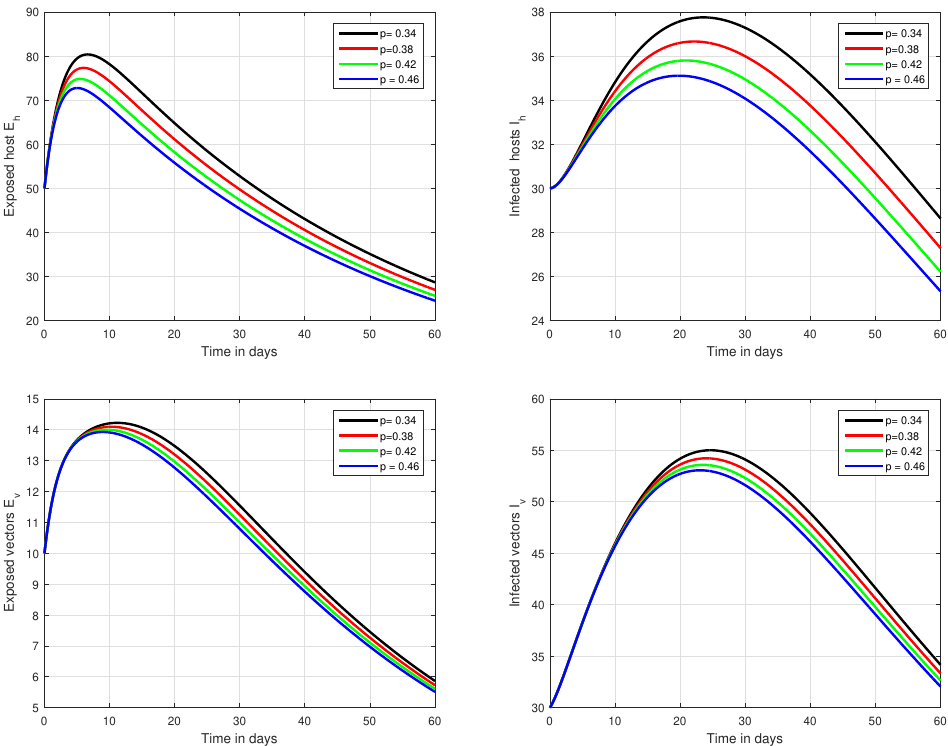
Figure 7. Illustration of the solution pathways of all the classes of our fractional model of Zika virus infection with various values of the input parameter p , i.e., p =